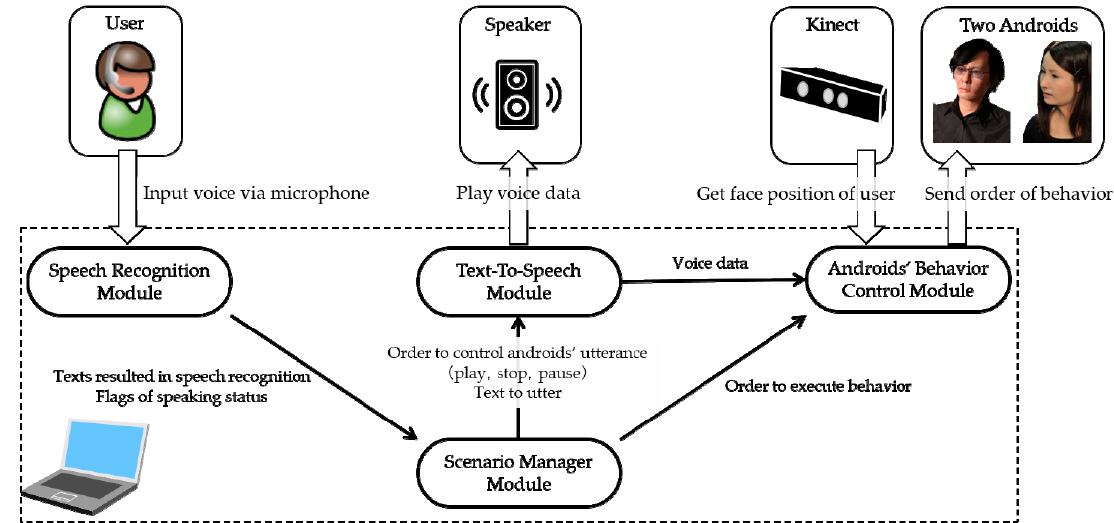
Figure 1. System diagram.